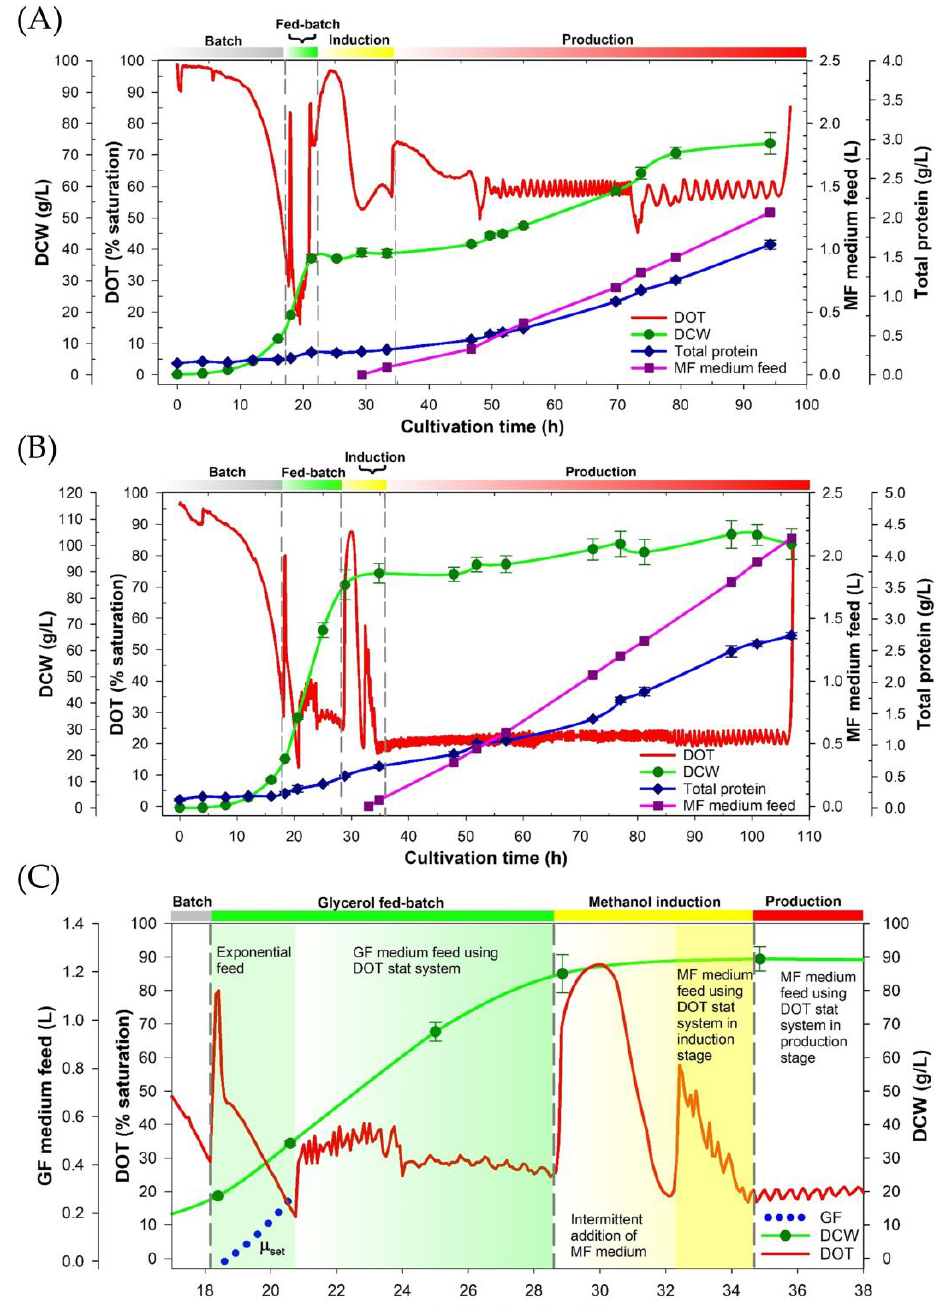
Figure 1. Fermentation profiles of the CAP2 candidate production in P. pastoris KM71H using the four-stage ( A ) and improved fermentation processes ( B , C ). ( A ) DCW, DOT, MF medium feed, and total protein profiles of the four-stage fermentation process (process time = 95.17 h). ( B ) DCW, DOT, MF medium feed, and total protein profiles of the improved fermentation process (process time: 106.88 h). ( C ) GF medium feed, DOT, and DCW profiles during the early and late glycerol fed-batch stages, the early and late induction stages, and the production stage of the improved fermentation process. Error bars indicate the standard deviation of technical triplicates. During the glycerol fed-batch stage of both fermentation processes, the total protein was slightly increased. The tricine SDS-PAGE results of the culture supernatant from the